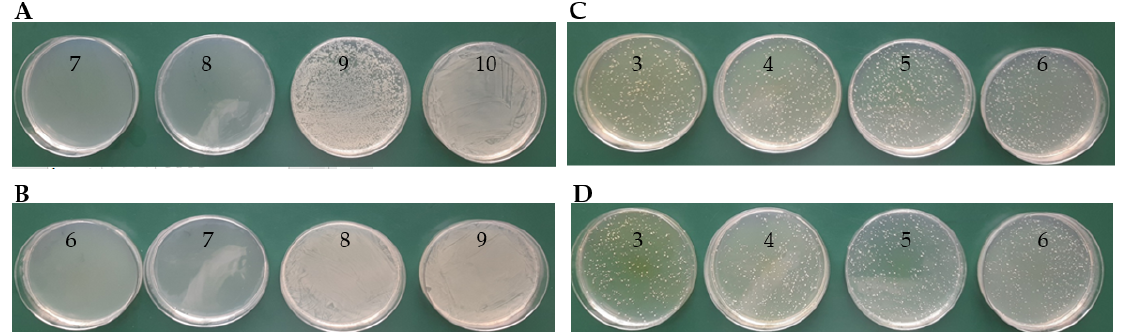
Figure 10. Determination of MBC on MHA agar plates for E. coli in the presence of complexes: ( A ): TY-Ag (1:0.5) (last of concentration No. 8: 0.036 mM); ( B ): BSA-TY-Ag (last of concentration No. 7: 0.07 mM); MBC determination for S. aureus in the presence of complexes: ( C ): TY-Ag (1:0.5) (above concentration No. 3: 1.12 mM—MBC not determined); ( D ): BSA-TY-Ag (TY-Ag = 1:0.5; BSA-TY = 1:10) (above concentration no. 3: 1.12 mM—MBC has not been determined). The ranges of silver concentrations (serial two-fold dilutions) were analyzed from 1.12 mM (No. 3) to 0.008 mM (No. 10).